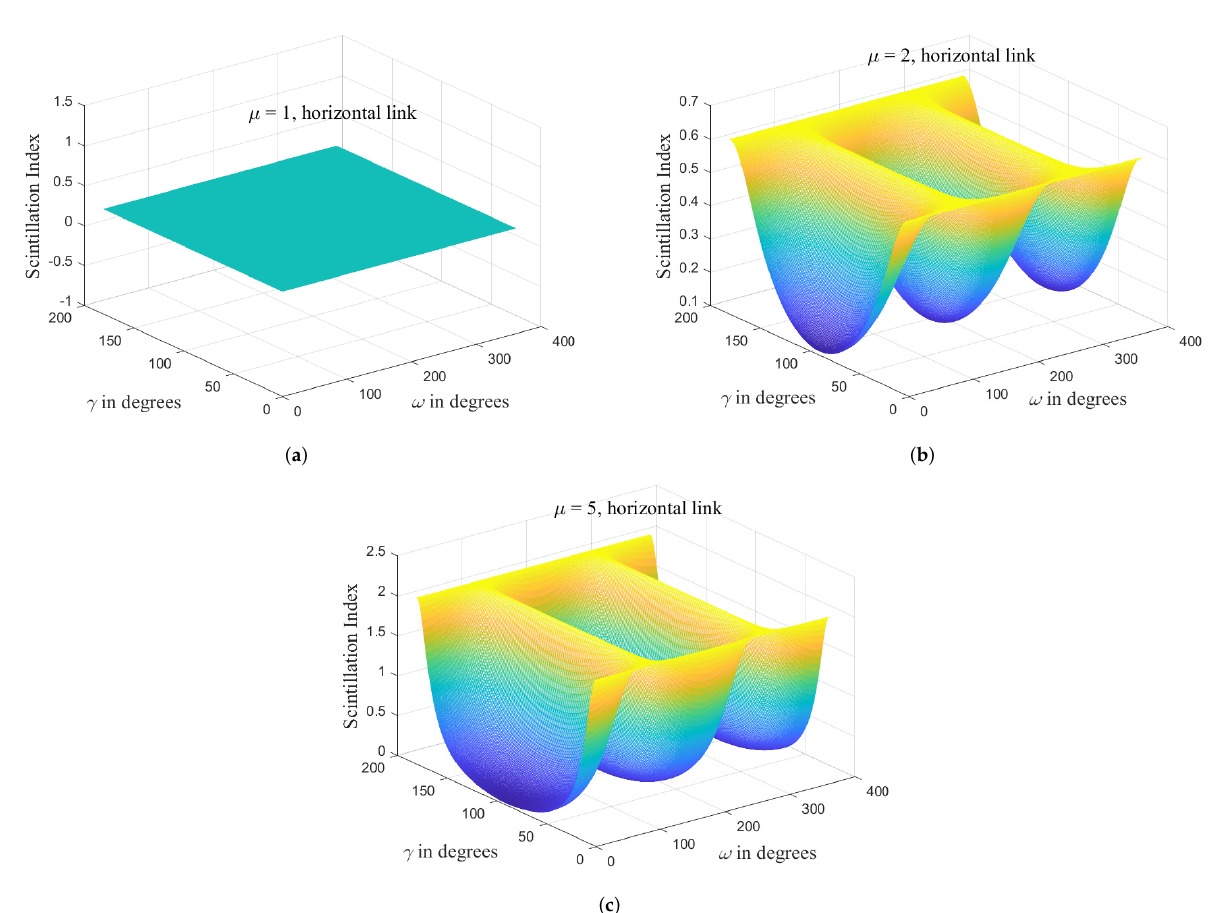
Figure 2. Scintillation index of horizontal link as the function of anisotropic tilt angle γ and azimuth angle ω for several values of anisotropic factor µ , with ( a ) for µ = 1, ( b ) for µ = 2, and ( c ) for µ =